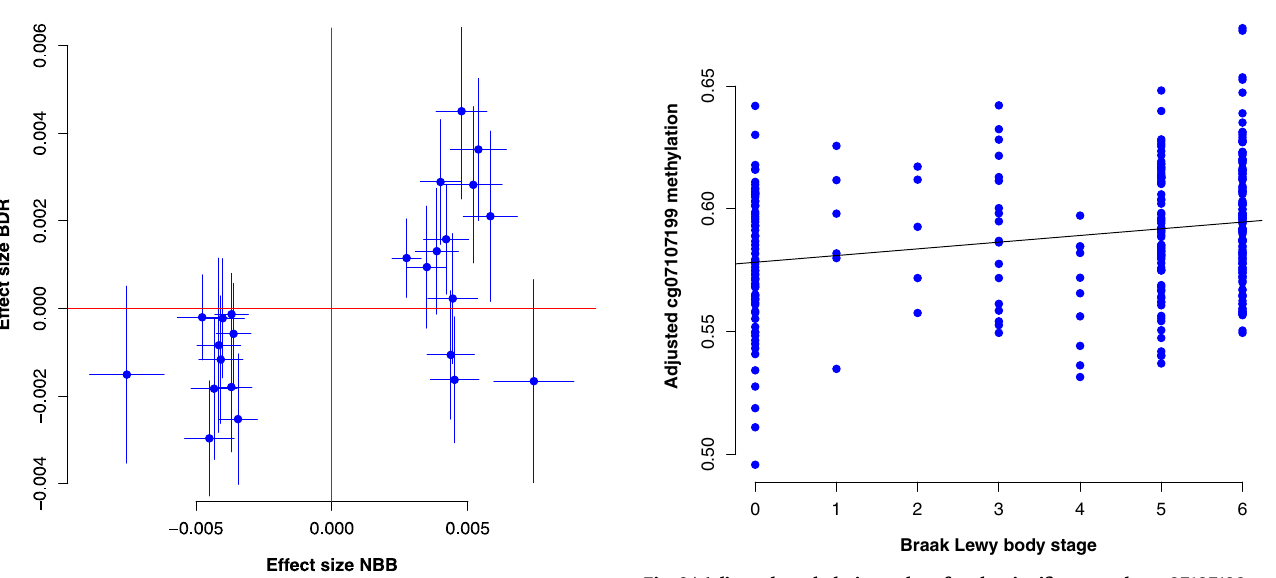
Fig.2|Correlationbetweeneffectsizeindiscoveryandreplicationdatafortop probes. The fi gure shows the coef fi cients±SE from linear regression for the 24 probes passing a false discovery rate threshold (two-sided FDR<0.05) in the dis- covery stage. A strong correlation between the discovery (NBB, Netherlands Brain Bank, n =322 biologically independent samples) and replication (BDR, Brains for Dementia Research, n =200 biologically independent samples) analyses indicates consistentresults(Pearson r 2 0.61,two-sided p =0.0015,87.5%concordantdirection, binomialsigntesttwo-sided p =0.00028).Thinbluelinesrepresentstandarderrors.